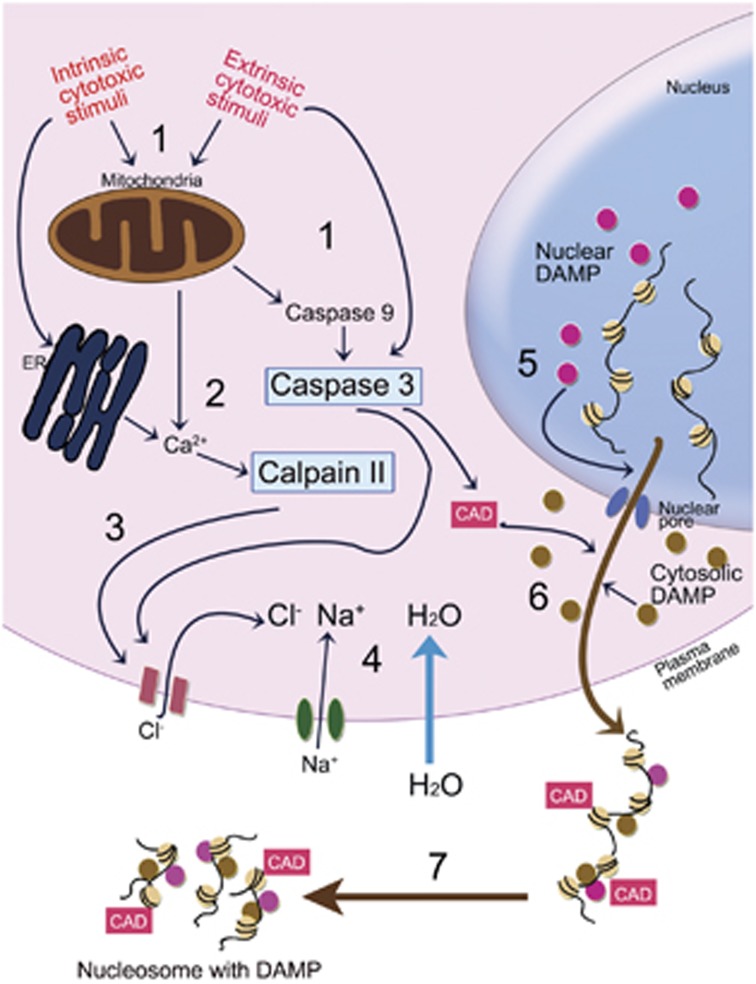
Schematic diagram showing the suggested molecular mechanisms of caspase-dependent regulated necrosis. Caspases 9 and 3 are sequentially activated by various cytotoxic stimuli (1). At the same time, focally released Ca2+ from either ER or mitochondria in the cellular stress activates calpain II (2), which opens Cl− ion channels of plasma membrane cooperating together with caspase 3 by unknown mechanisms (3). Cl− influx and secondary Na+ influx, mediated by voltage gradient produced by Cl− influx, induce osmotically driven water movement into cytosol and subsequent cellular swelling (4). Hydrostatic pressure, generated by intracellular water increment, squeezes out nuclear chromatin through nuclear pore damaged by caspases to be released extracellularly by way of cytosol. During that time, nuclear and cytosolic DAMPs and discharged CAD from ICAD by caspase 3 are attached to the released chromatin (5, 6). Finally, the extracellular chromatin and its attached DAMPs are partially digested into poly- or oligo-nucleosomes with DAMPs by the CAD (7)